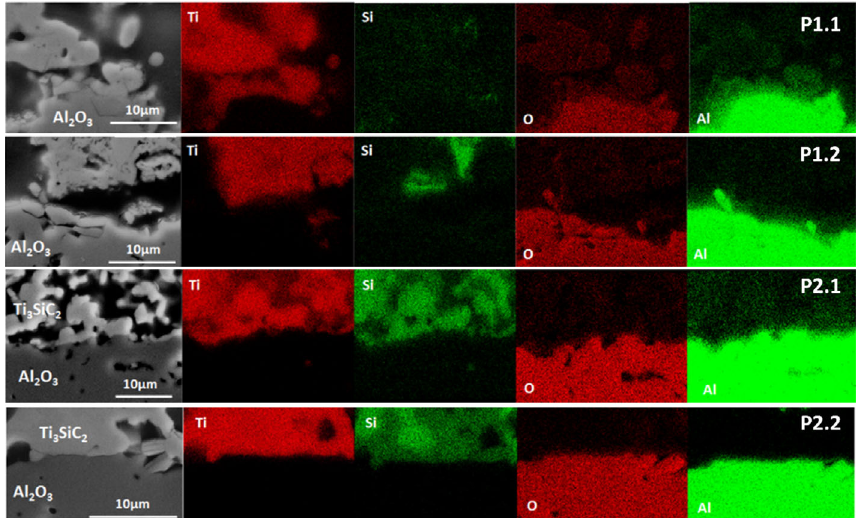
Fig. 7 EDX mapping of screen printed films after 5 h sintering at 1400 ℃ in argon. The highlighted colored regions denote for different detected